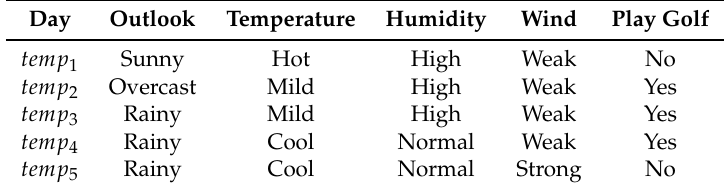
( u )))) , temp ( MV ( g cd 1 0.5, l 1 0.5, l 2